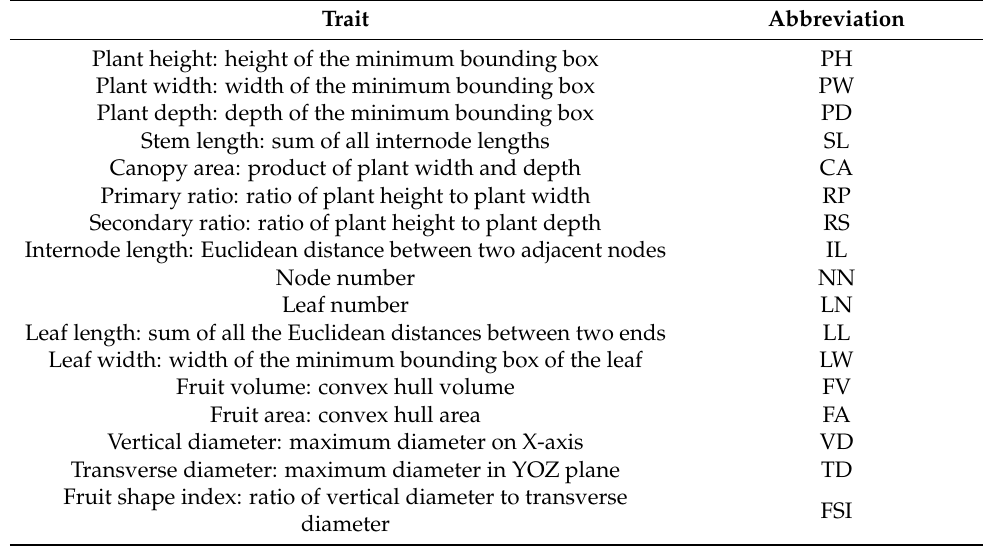
Table 1. Seventeen 3D phenotypic traits measured by the 3DPhenoMVS pipeline. Trait